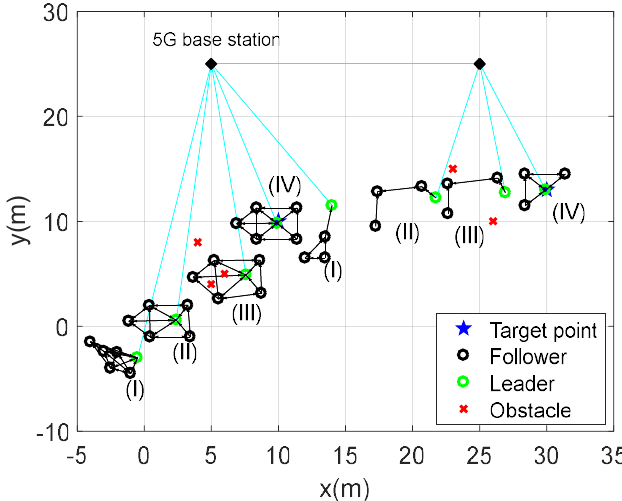
Figure 8. Motion process when information interaction between clusters is considered. The figure describes the motion of clusters in the process of performing the task, which can be also divided into four cases. In the process of movement, cluster heads will select the base station with better channel conditions to connect, and other clusters will be connected through the base station. The blue lines in the figure represent 5G